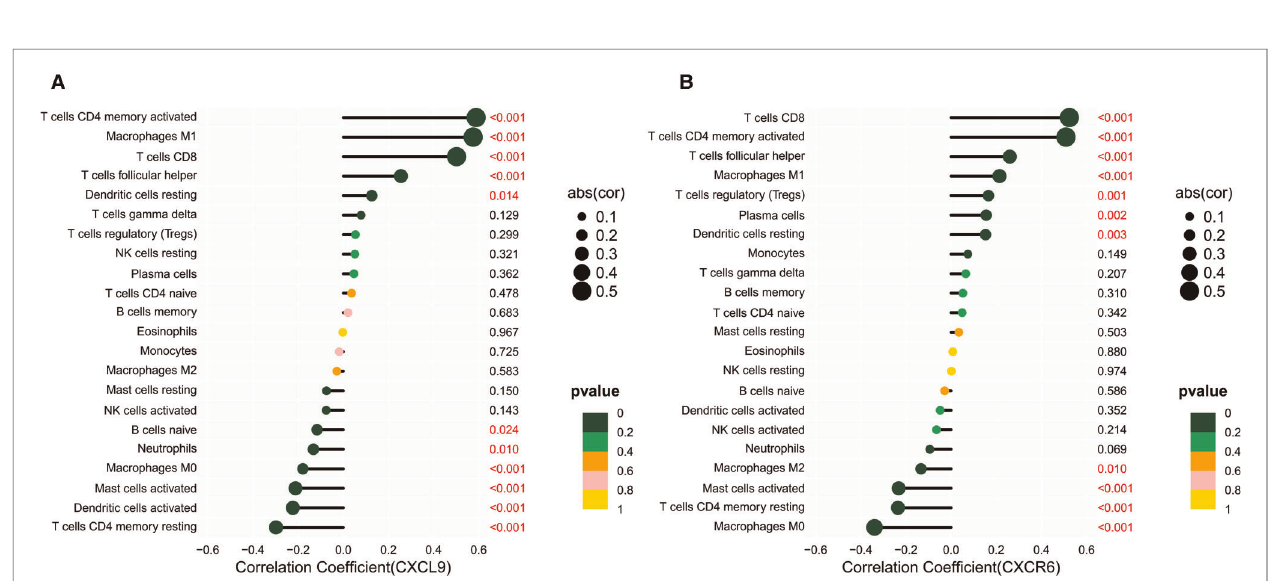
FIGURE 7 | Survival analysis. ( A – J ) Kaplan – Meier curve illustrating the prognostic values of 10 HUB genes [CD274(PD-L1), CXCR6, CXCL9, CCL18, CXCL10, STAT1, IL10, CD4, FCGR3A, C1QA].